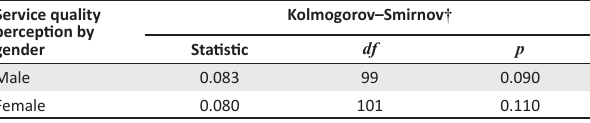
TABLE 7: Test of normality of distribution of responses (service quality perception and gender). Service quality perception by